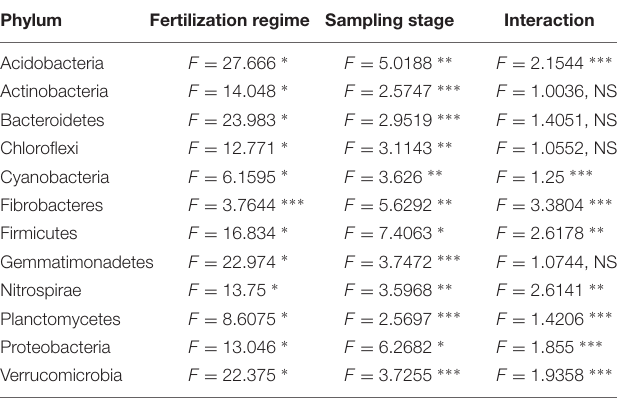
TABLE 5 | Values obtained for Two-Way PERMANOVA for each phylum calculated to check the importance of fertilization regime (organic N, zero N, medium inorganic N and high inorganic N), sampling stage (4 and 10 weeks) and their interaction on the structure of rhizosphere bacterial communities.